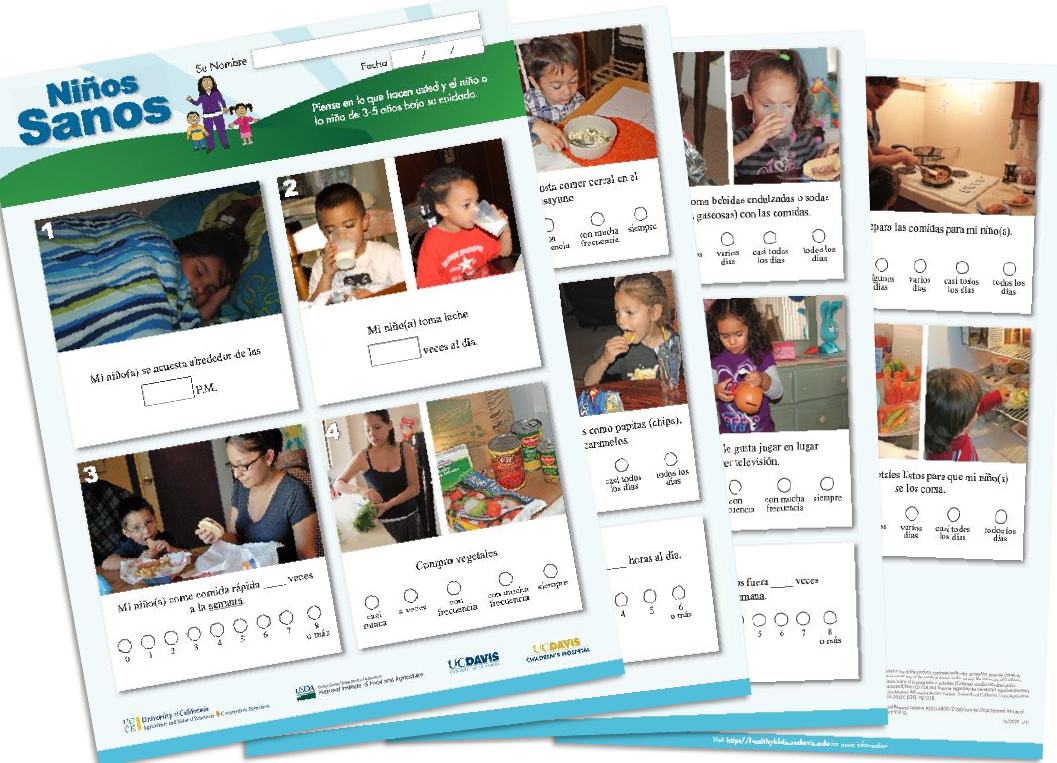
Figure 2. Niños Sanos Obesity Risk Assessment, final version with 18 items, tailored to limited literacy parents of 2-5 year old children. *